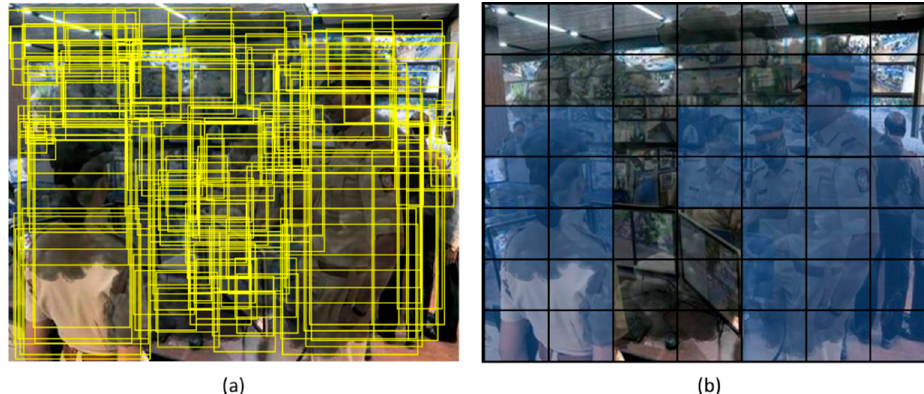
Figure 7. ( a ) Bounding boxes + confidence; ( b ) Class probability map.